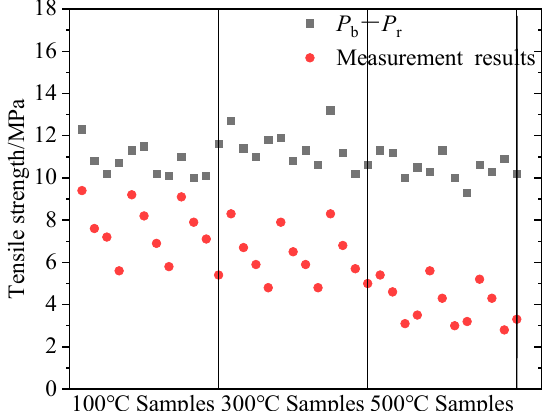
Figure 16. Variation of measured and calculated tensile strength with temperature for all lithological samples.